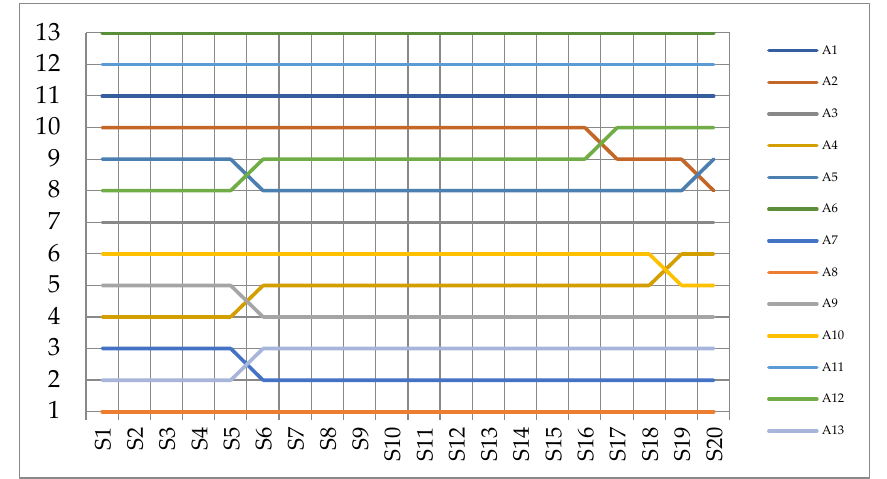
Figure 3. Rank of alternatives by scenarios.